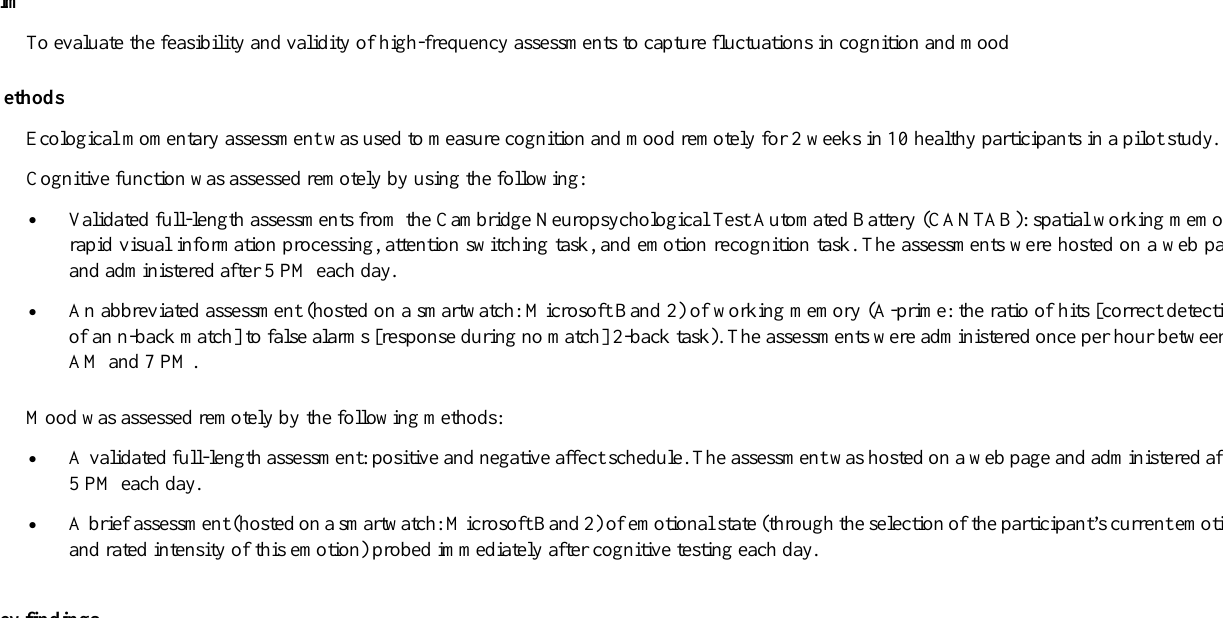
Textbox 2. Comparing high-frequency abbreviated assessments with low-frequency full-length assessments. Aim To evaluate the feasibility and validity of high-frequency assessments to capture fluctuations in cognition and mood